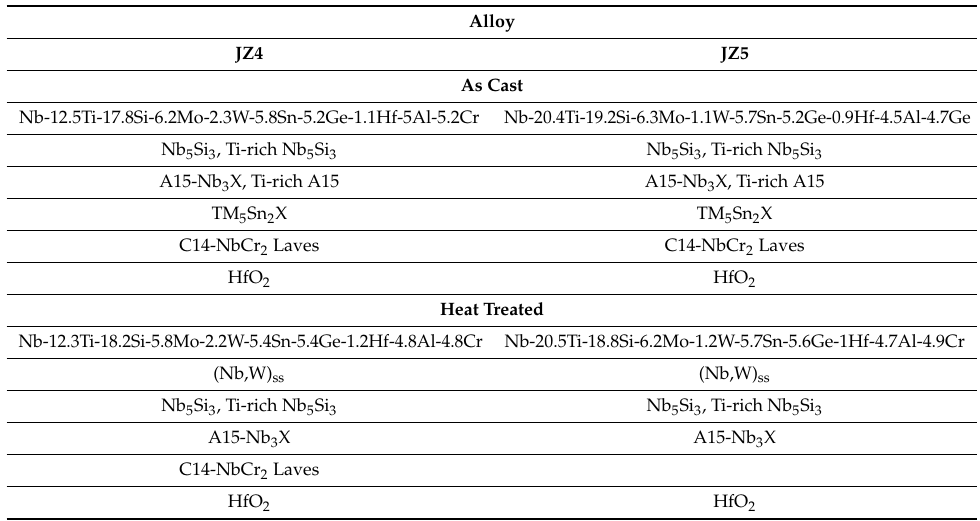
Table 2. Average chemical compositions (at.%) and summary of phases in the as-cast and heat-treated alloys JZ4 and